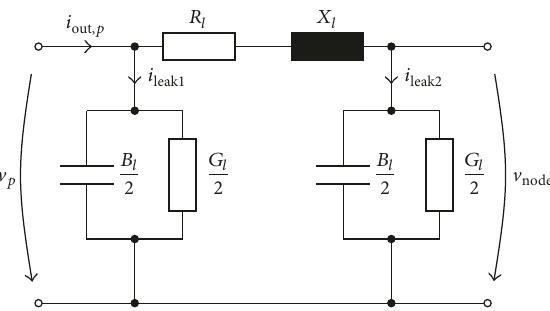
Figure 4: Single-phase reference circuit of a power